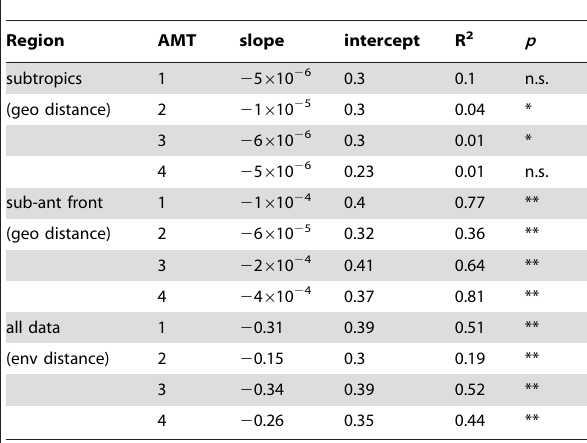
(Table 2). Across the sub-Antarctic front community similarity was correlated with environmental distance in AMT 3–4, and with geographic distance in AMT 2. Community similarity was correlated with both environmental and geographic distance in Table 1. Statistical parameters for the relationship between community similarity and, geographic distance, and environmental distance.